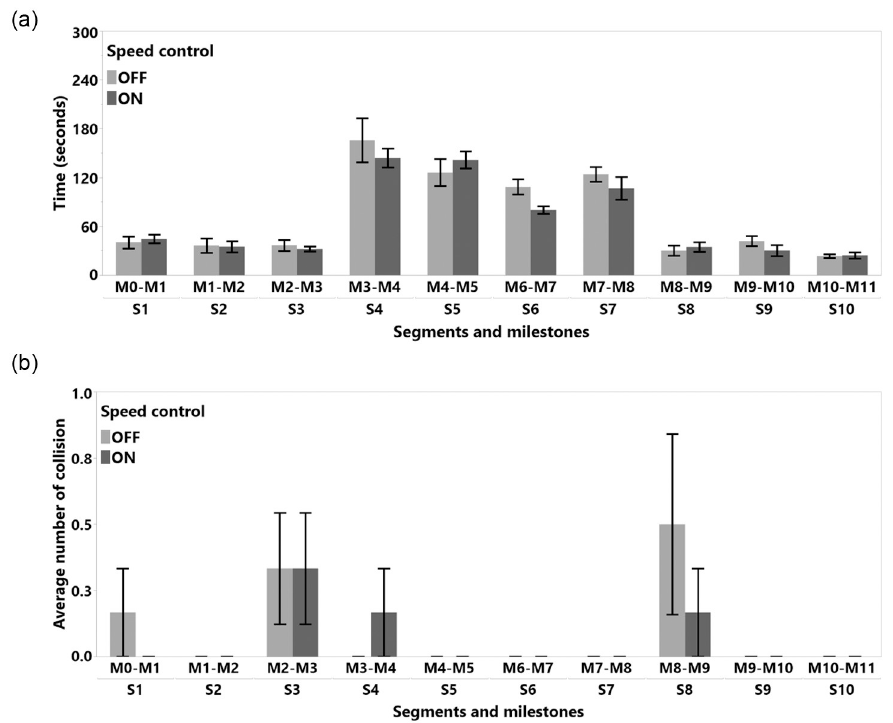
Fig 19. Study 2 detailed milestone analysis for (a) task completion time and (b) average number of collision.